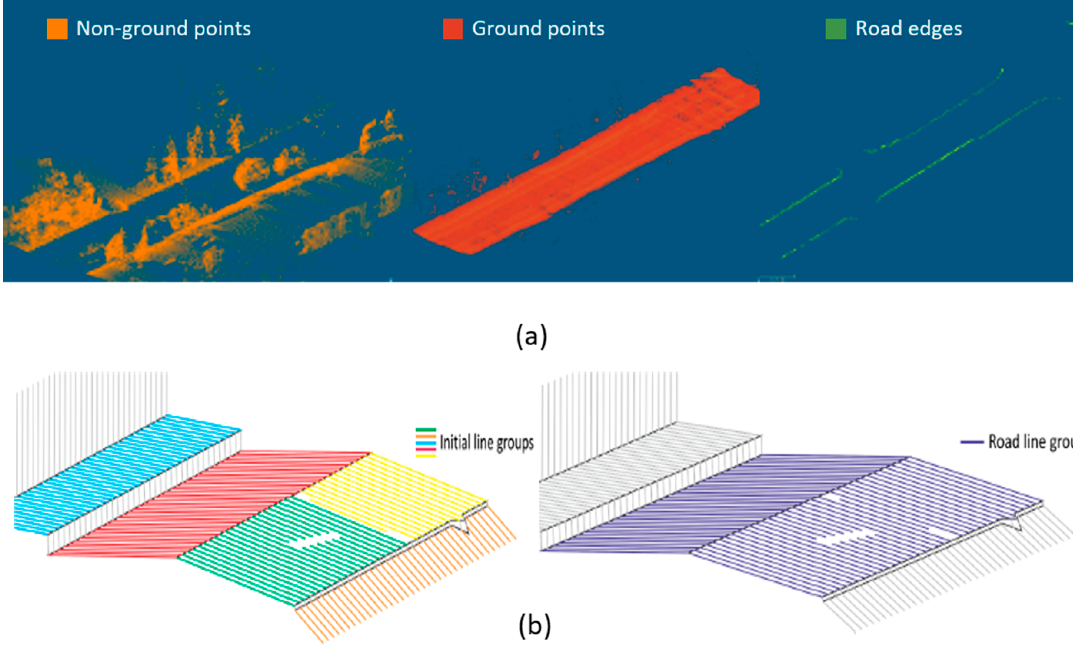
Figure 3. Road surface extraction. ( a ) Ibrahim and Lichti [50] segment non-ground (left) and ground (center) using a density-based filter. Then, a 3D edge detection algorithm based on local morphology and Gaussian filtering extracts road edges (right). ( b ) Cabo et al. [64] scan lines are grouped based on length, tilt angle and azimuth, and the initial groups (left) are joined following predefined rules using the vehicle trajectory to define the road surface